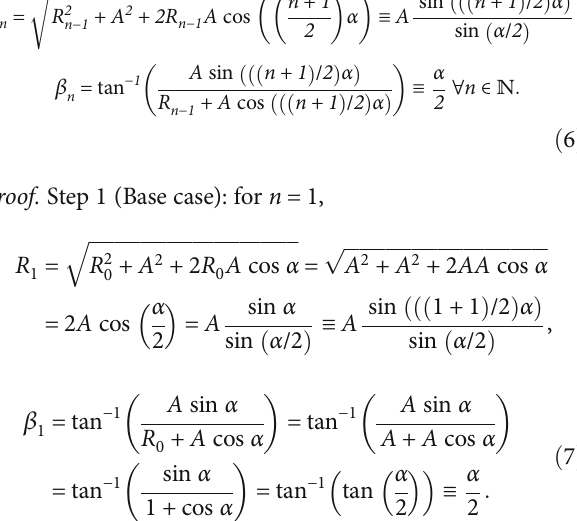
R , R , R , ⋯ , R 1 2 3 N − 1 g with